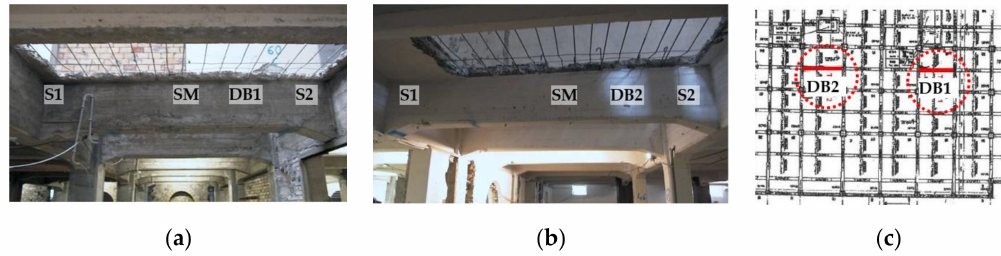
Figure 1. Beams DB1 ( a ) and DB2 ( b ) in the RC building at the basement floor ( c